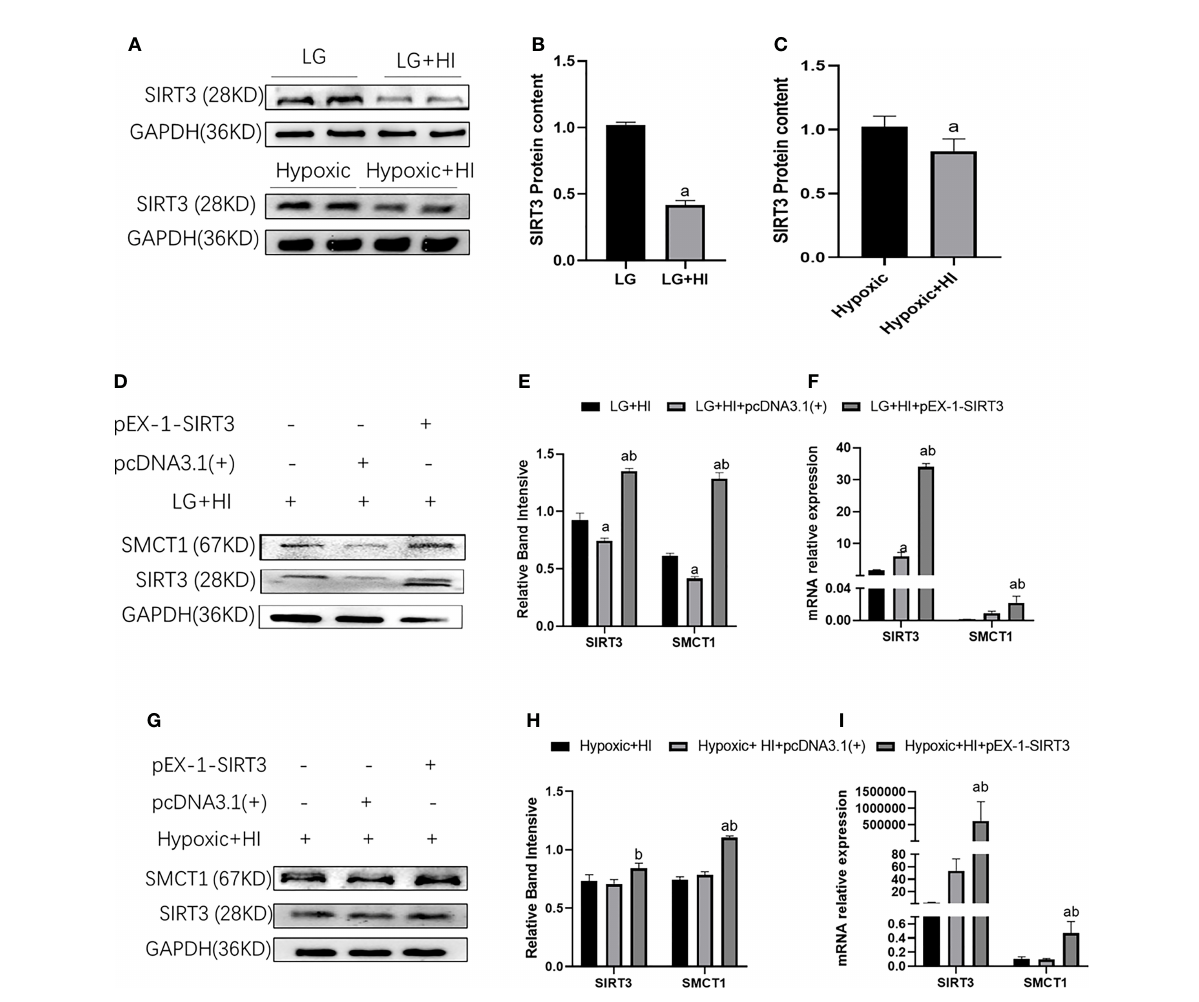
FIGURE 13 High insulin inhibits SMCT1 expression by suppressing SIRT3 expression. (A) Expression of SIRT3 expression; (B) Quantitative results of the corresponding protein expression in (A) ; (C) Quantitative results of SIRT3 mRNA expression. (D, G) Expression of SIRT3 and SMCT1; (E, H) Quantitative results of SIRT3 and SMCT1 expression; (E, H) Quantitative results of SIRT3 and SMCT1 mRNA expression. In panels (B) a p < 0.05, compared with the LG group, in Figure (C) a p < 0.05, compared with the Hypoxic group, in panels (E, F) a p < 0.05, compared with the LG + HI group; b p < 0.05 compared with the LG + HI + pcDNA3.1(+) group; in panels (H, I) a p < 0.05, compared with the Hypoxic + HI group; b p < 0.05, compared with the Hypoxic + HI + pcDNA3.1(+)